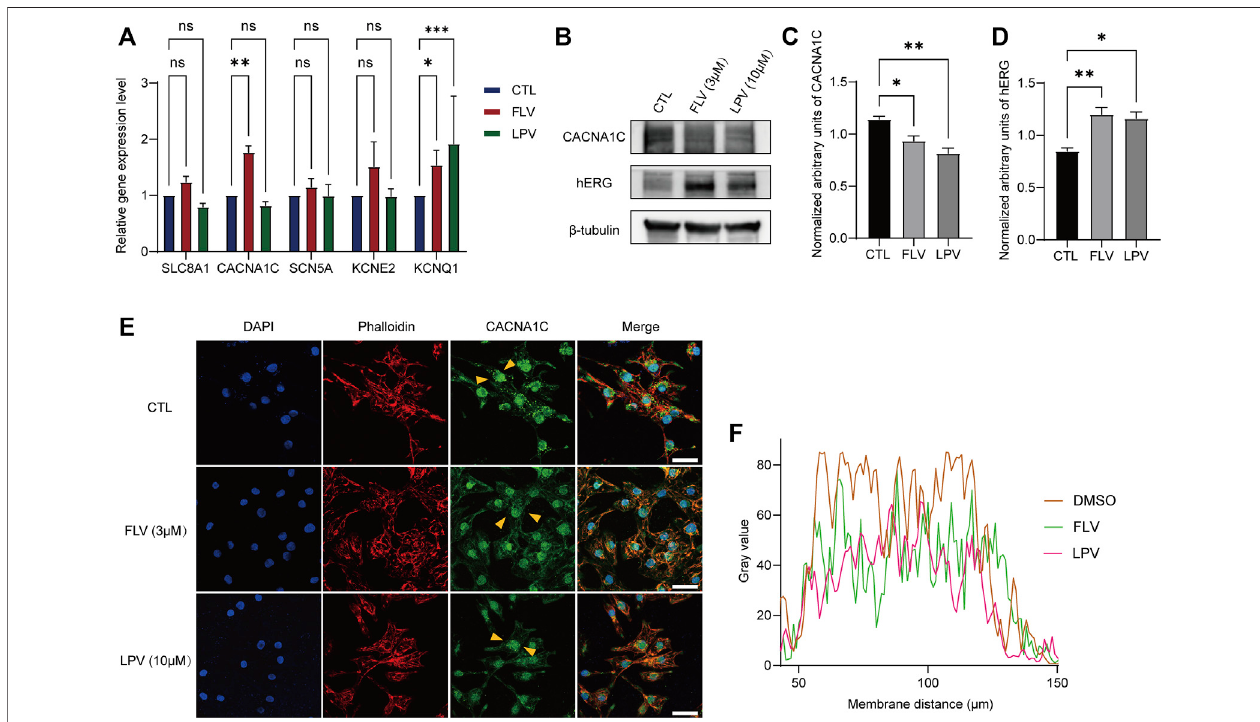
FIGURE 8 | FLV and LPV inhibit L-type calcium channels. (A) Relative nucleic acid expression levels of cardiac ion channels determined by real-time quantitative PCR (RT-qPCR) with GAPDH as the housekeeping gene. (B) Immunoblotting of L-type calcium channel protein Cav1.2 (CACNA1C) and hERG protein in the presence and absence of drug incubation, with β -tubulin as an internal reference. (C,D) Assessment of band densities of normalized CACNA1C and hERG, respectively. (E,F) Immunostaining of hiPSC-CMs stained with CACNA1C (green), F-actinin (red, phalloidin), and DAPI (blue) before (CTL) and after 72 h of 3 μ M FLV and 10 μ M LPV treatment. Yellow arrows represent typical areas of fl uorescence intensity evaluation, as shown in a line scan plot. Scale bar: 10